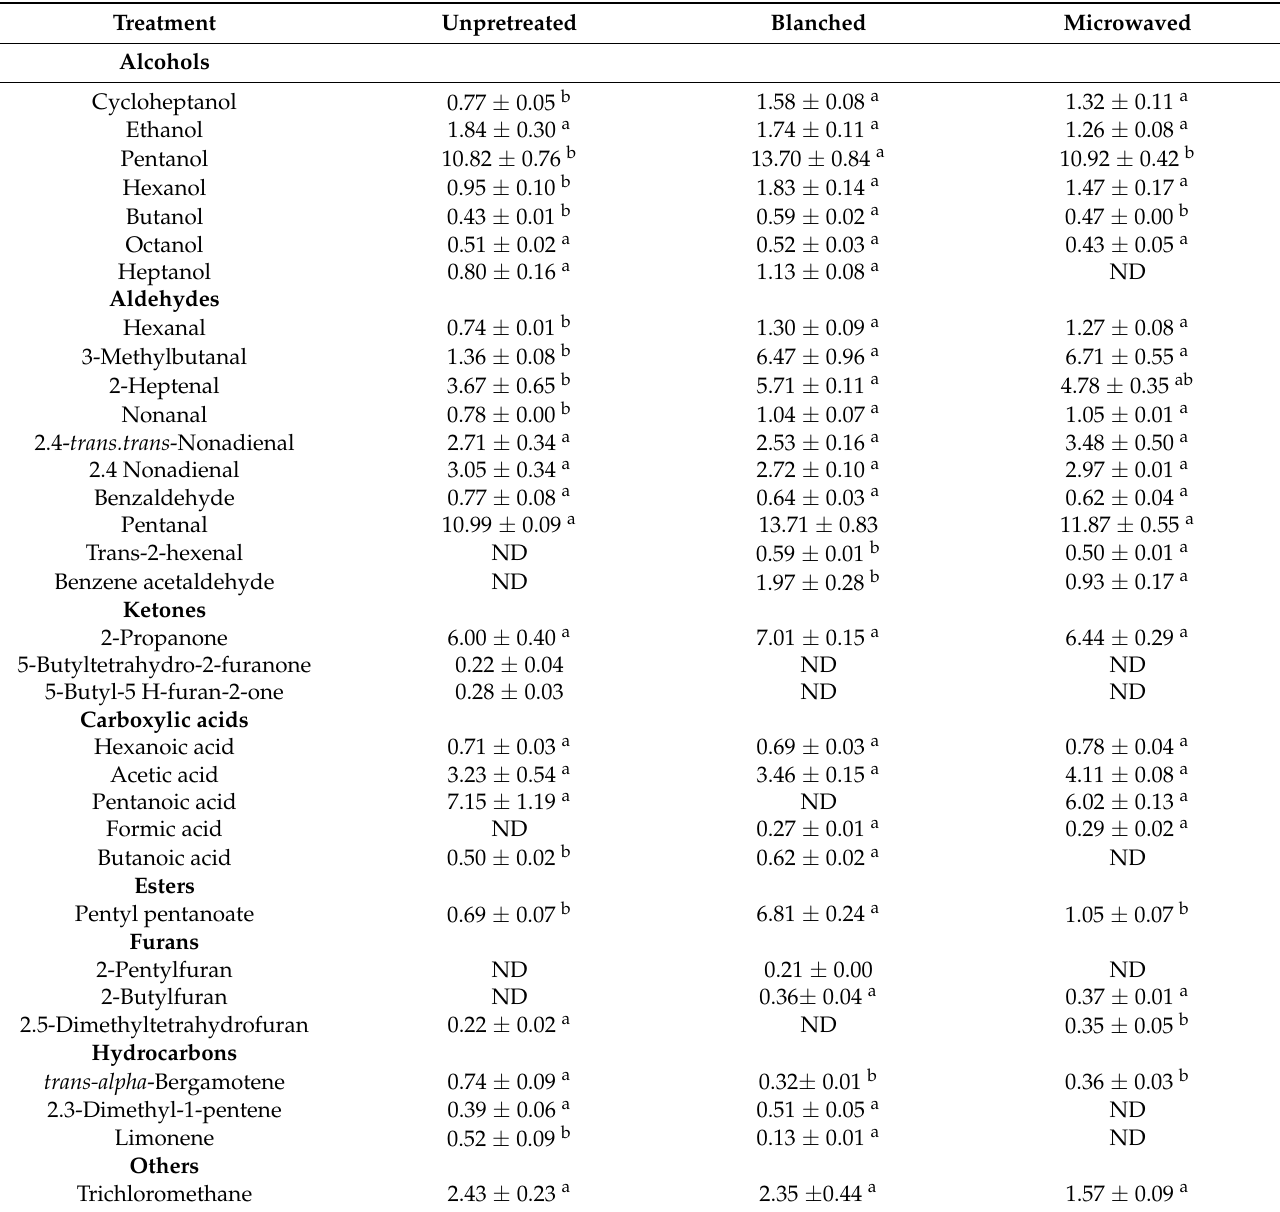
Table 3. Volatile compounds of cold-pressed pomegranate seed oil from unpretreated, blanched (95 ± 2 ◦ C/3 min), and microwave-heated (261 W/102 s)